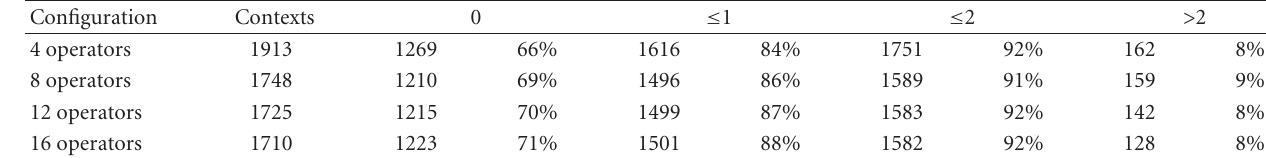
Table 4: Overall utilization of complex processing elements in synthesized functional units.